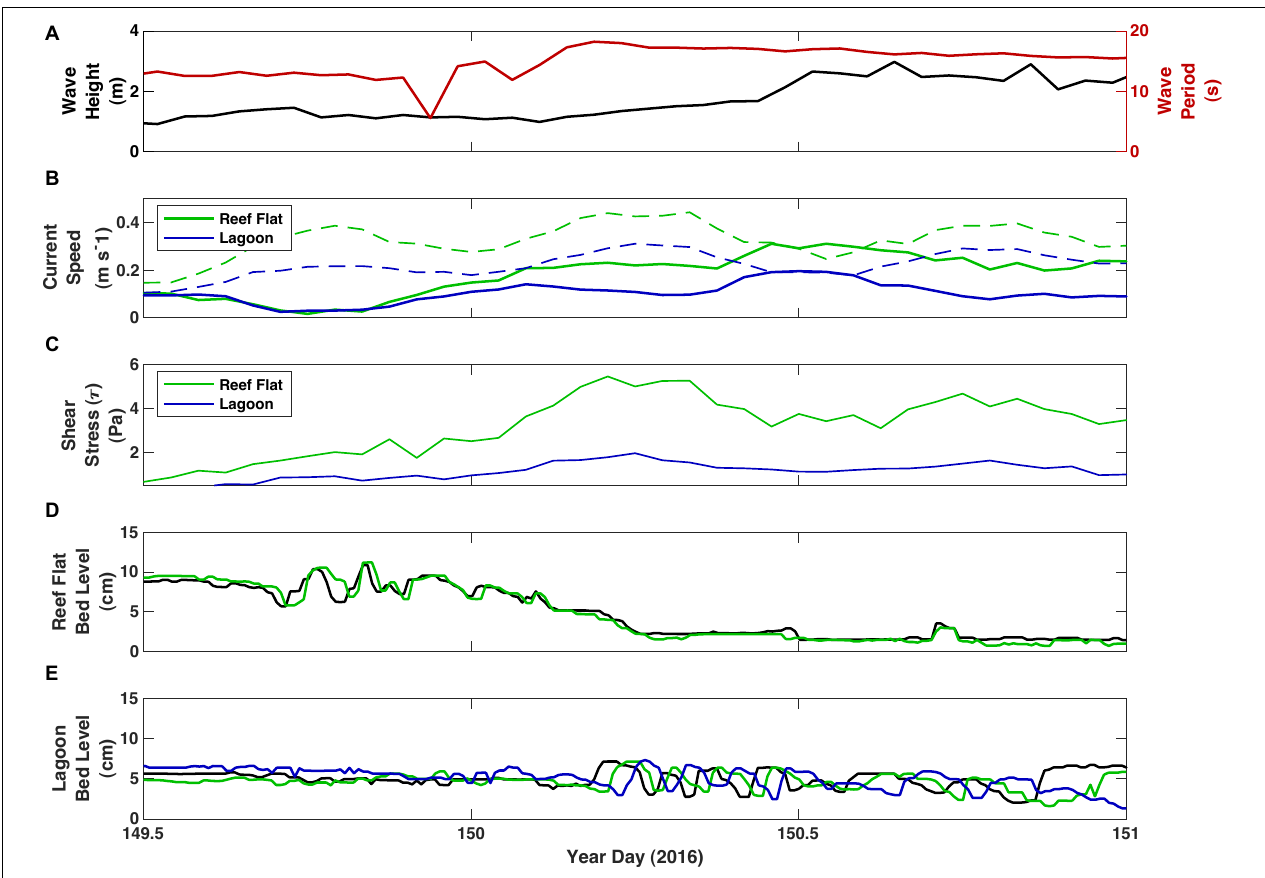
FIGURE 9 | Wave and current parameters and bed elevation from TR2 on the inner reef flat and TR3 in the lagoon during a transition period when ripples on the reef flat were washed out and sediment input to the lagoon peaked. (A) Offshore significant wave height (black) and peak wave period (red). (B) Burst mean current speed (solid) and wave orbital velocity (dashed) on the reef. (C) Total shear stress ( τ ) (D) Bed altimetry at TR2 on the inner reef flat. (E) Bed altimetry at TR3 in the lagoon. Colors in panels (D,E) represent data from individual altimeters, in order from offshore to onshore, black, green and